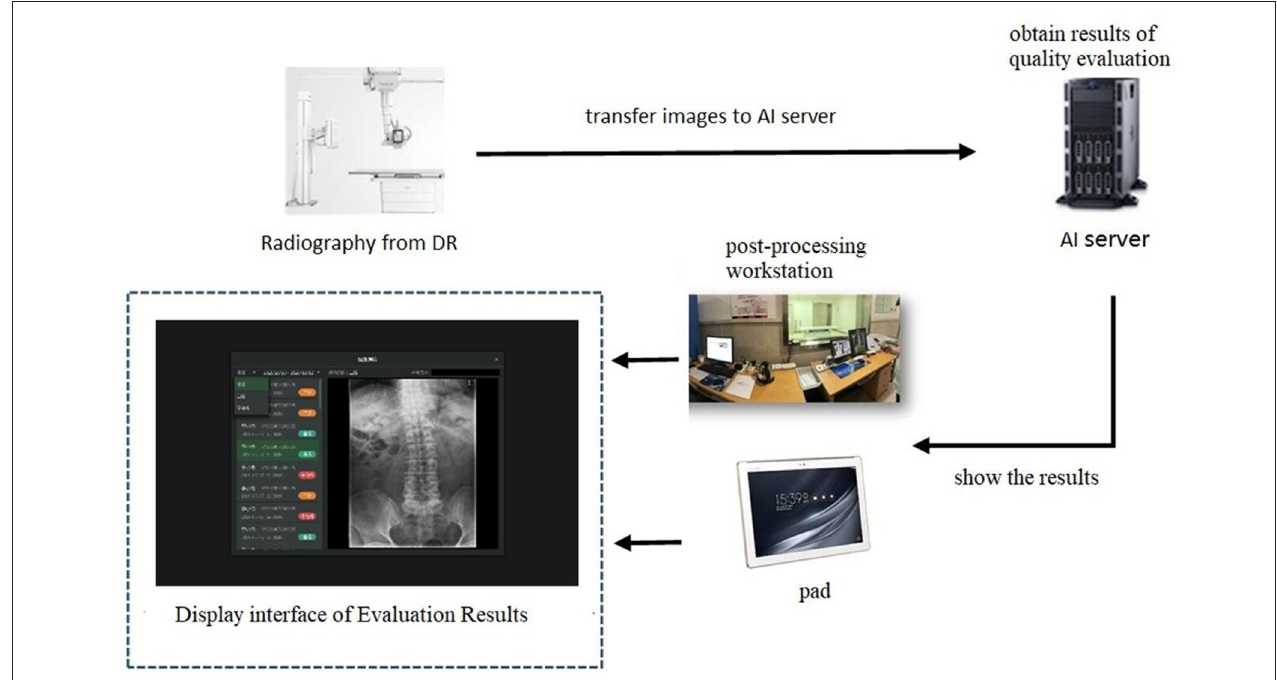
FIGURE 6 | The application of Lumbar Spine X-ray radiography quality control